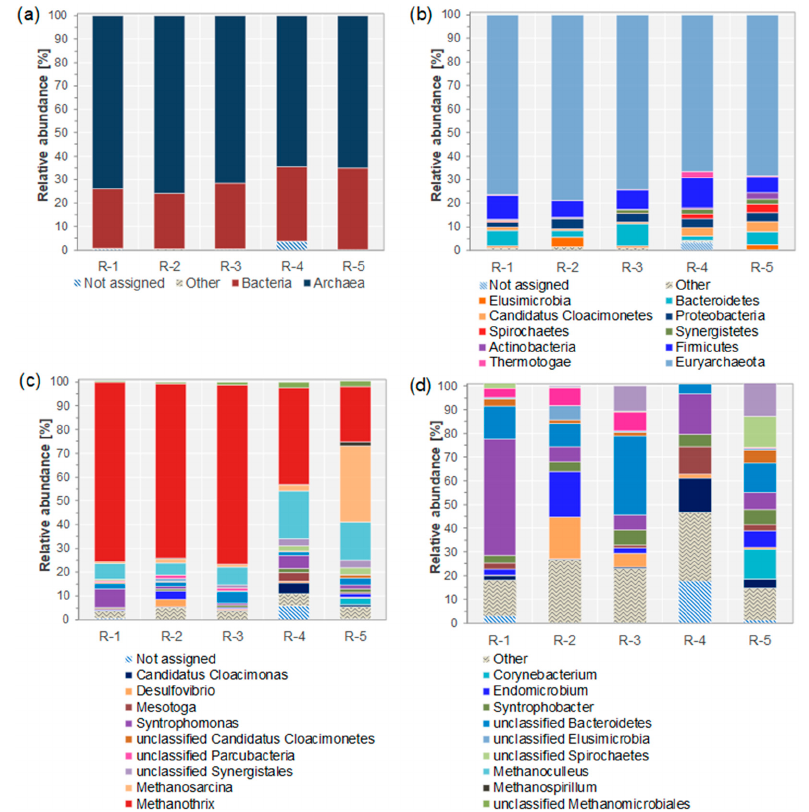
Figure 1. Microbial community composition at domain ( a ), phylum ( b ), and genus level ( c ), and composition of the bacterial communities only at genus level ( d ). Relative abundances were calculated using read counts per taxon. In all panels, not assigned refers to reads without hits on the respective taxonomic level as well as unclassified reads. Other refers to reads assigned to other domains ( a ), phyla, respectively, genera, with relative abundances below 1% ( b , c ), and bacterial genera with relative abundances below 5% ( d ). Panels ( c , d ) share the same legend.